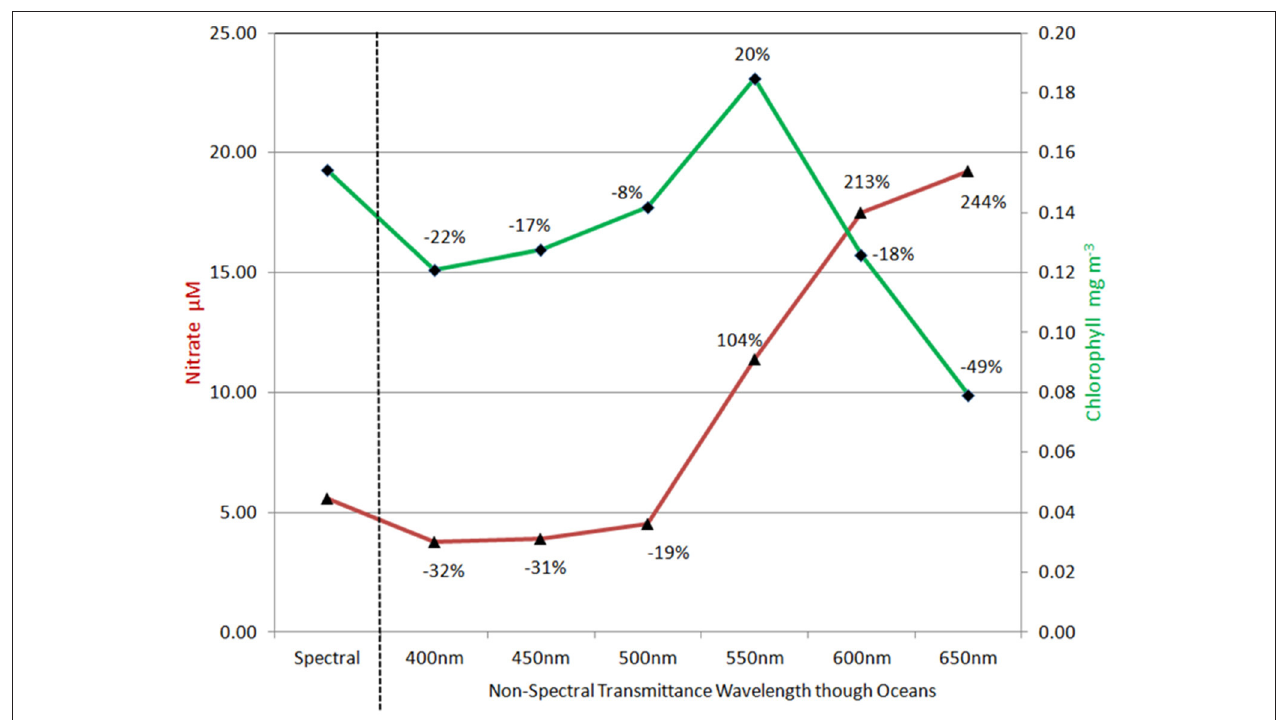
FIGURE 6 | Global nitrate and chlorophyll concentrations using non-spectral transmittance of irradiance. The non-spectral attenuation is shown for six different bands, each beginning with the same total surface irradiance as the spectrally resolved model. The percent change is relative to the spectrally-resolved model. Nitrate is shown in red and follows the left vertical